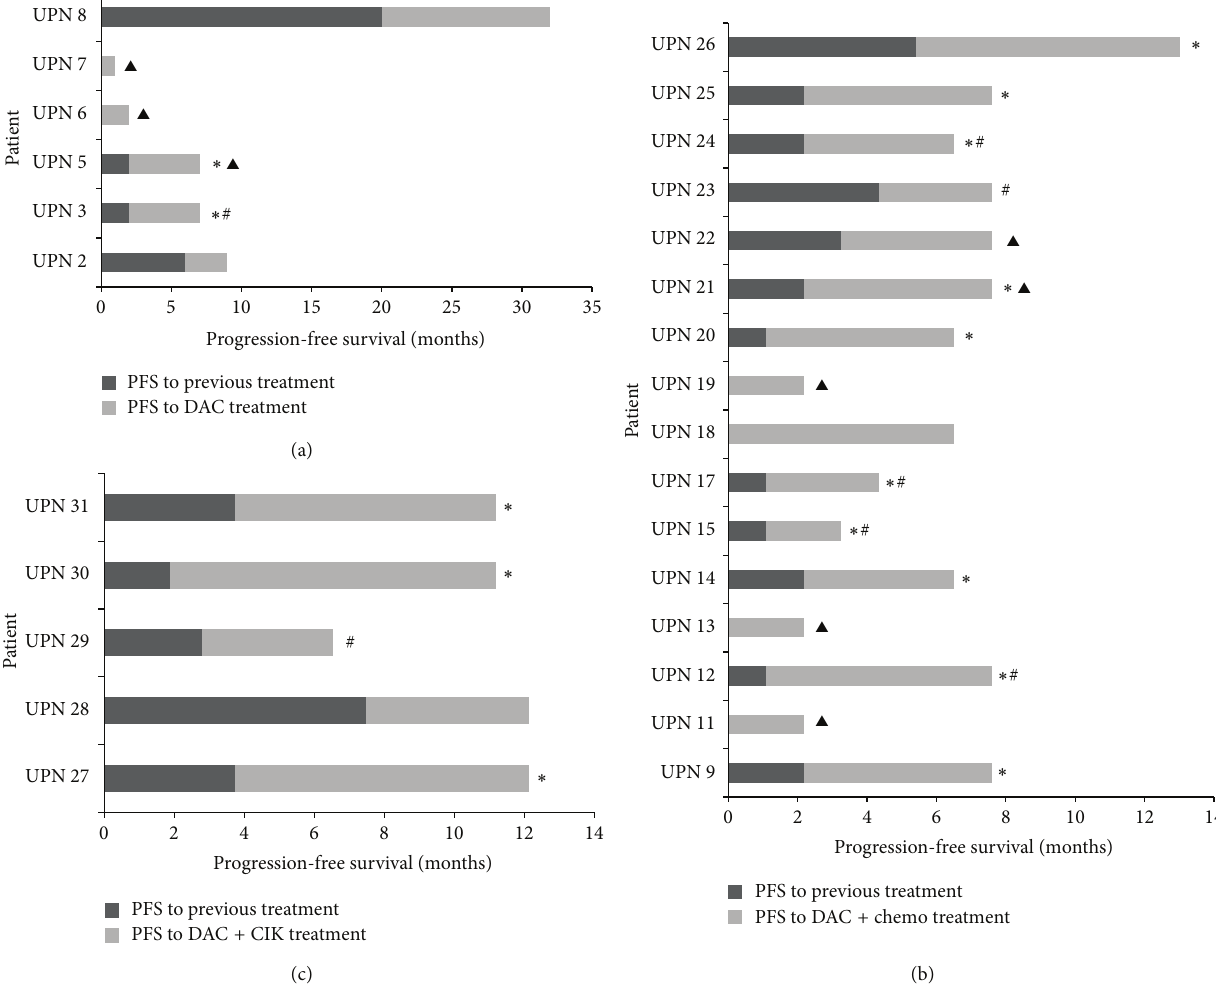
Figure 4: Swim plot showing the increase in progression-free survival (PFS) compared with the patients’ previous therapies. The bars represent the progression-free survivals (PFSs) of the DAC (a) and DAC combined with chemo (b) or CIK (c) versus the PFSs following the patients’ previous therapies. Four patients had died by the first assessment (due to disease progression) and were therefore not evaluated. ∗ The patients’ progression-free survivals (PFSs) were significantly prolonged compared with those of previous therapies; 𝑃 value < 0.05 was considered significant. CIK: cytokine induced killer cells. # Patients with disease progression. 󳵳 Patients who